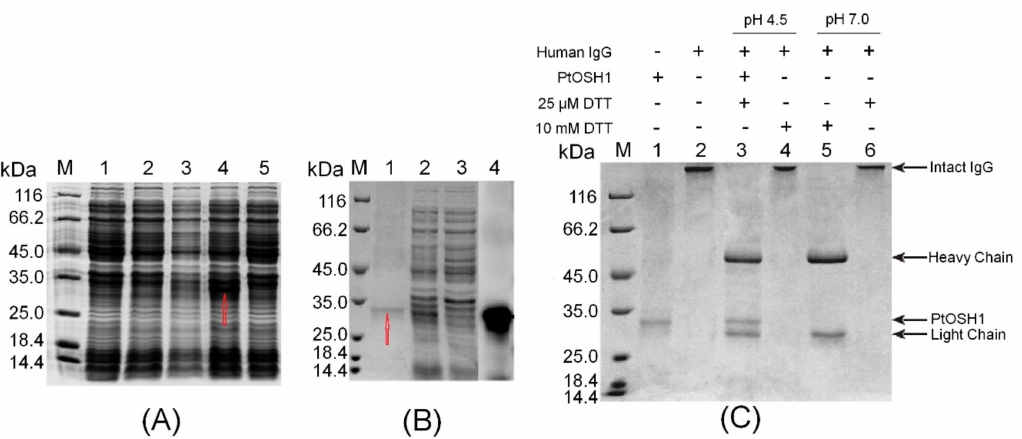
Figure 4. The identification of sulfhydryl reductase activity in vitro. ( A ) Analysis of recombinant PtOSH1 protein expression. Lane M, molecular mass marker; lane 1, control; lane 2, recombinant E. coli BL21 ( DE3 )incubatedat220rpmat37 ◦ Cwithinductionby1mMisopropyl β -D-1-thiogalactopyranoside (IPTG); lane 3, recombinant E. coli BL21 ( DE3 ) incubated at 110 rpm at 37 ◦ C with induction by 1 mM IPTG; lane 4, recombinant E. coli BL21 ( DE3 ) incubated at 110 rpm at 16 ◦ C with induction by 1 mM IPTG; and lane 5, recombinant E. coli BL21 ( DE3 ) incubated at 220 rpm at 37 ◦ C with induction by 1 mM IPTG. ( B ) Purification and western blot analysis of recombinant PtOSH1 protein. Lane M, molecular mass marker; lane 1, eluate; lanes 2–3, flow-through; lane 4, Western blot. ( C ) Analysis of PtOSH1 protein activity in vitro. Lane M, molecular mass marker; lane 1, recombinant PtOSH1 protein; lane 2, human IgG; lane 3, human IgG incubated with PtOSH1 protein (pH 4.5); lane 4, human IgG incubated with 10 mM dithiothreitol (DTT, pH 4.5); lane 5, human IgG incubated with 10 mM DTT (pH 7.0); and lane 6, human IgG incubated with 25 µ M DTT (pH